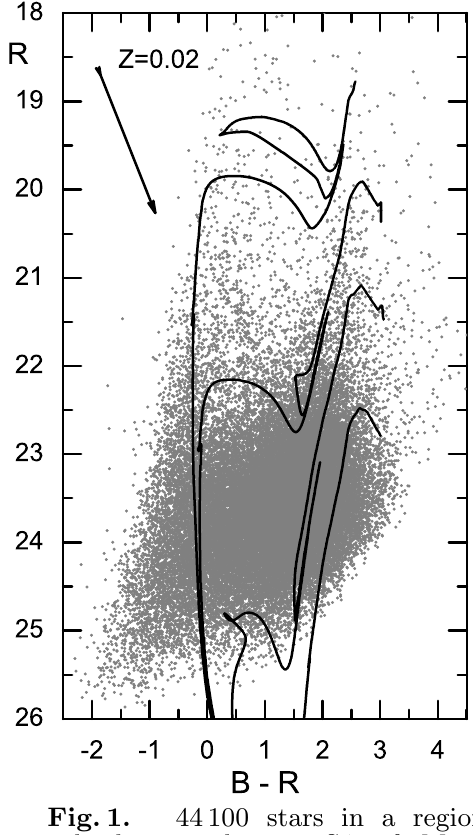
Fig. 1. 44 100 stars in a region around the spiral arm S4 of M 31. Isochrones: 50 Myr, 200 Myr, 1 Gyr and 10